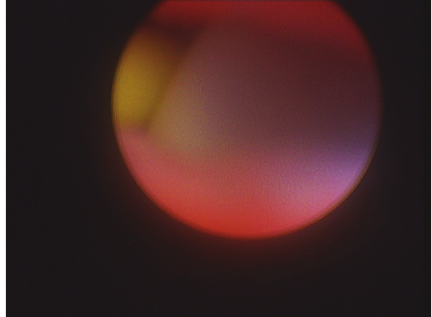
Figure 1: Cystoscopic view of Foley catheter extending through the ureteric orifice and up the ureter.